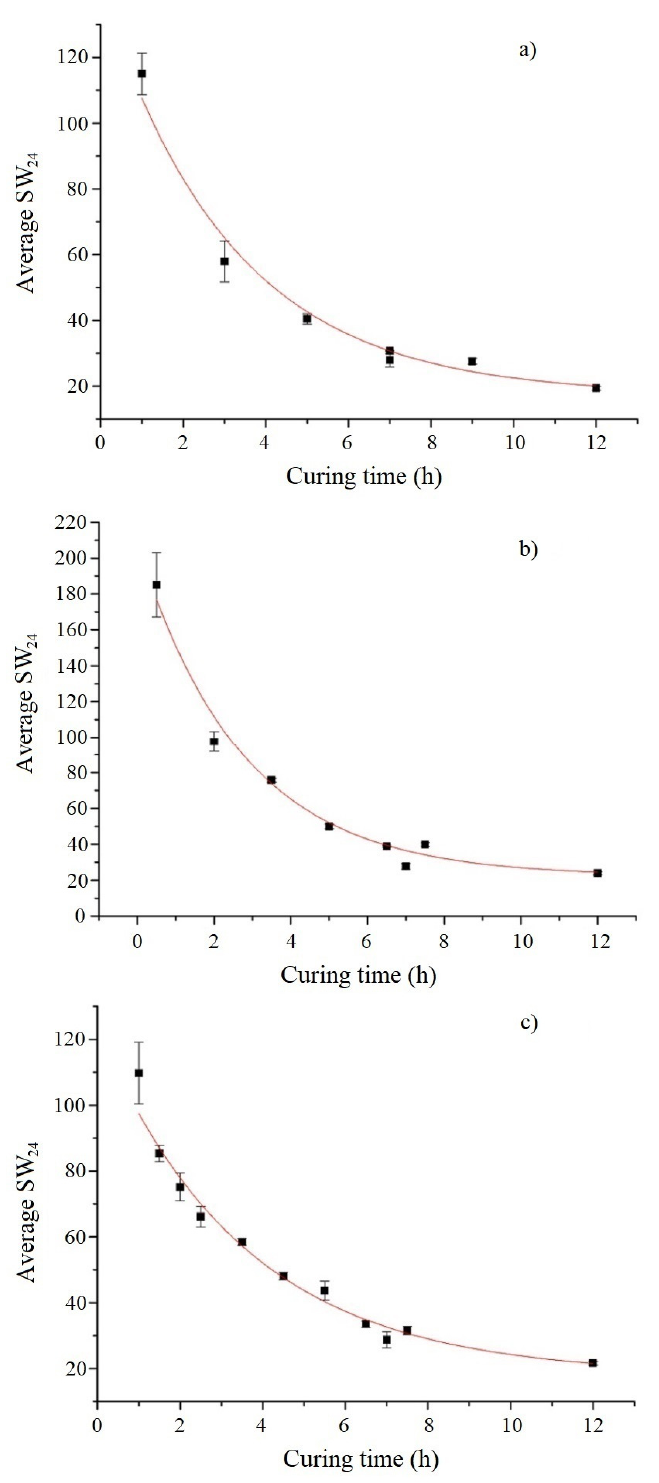
Figure 5. Correlation between curing time and swelling degree (SW 24 ) of the ( a ) 10% w / w AHum suspension; ( b ) 30% w / w AHum suspension; ( c ) 50% w / w AHum suspension.